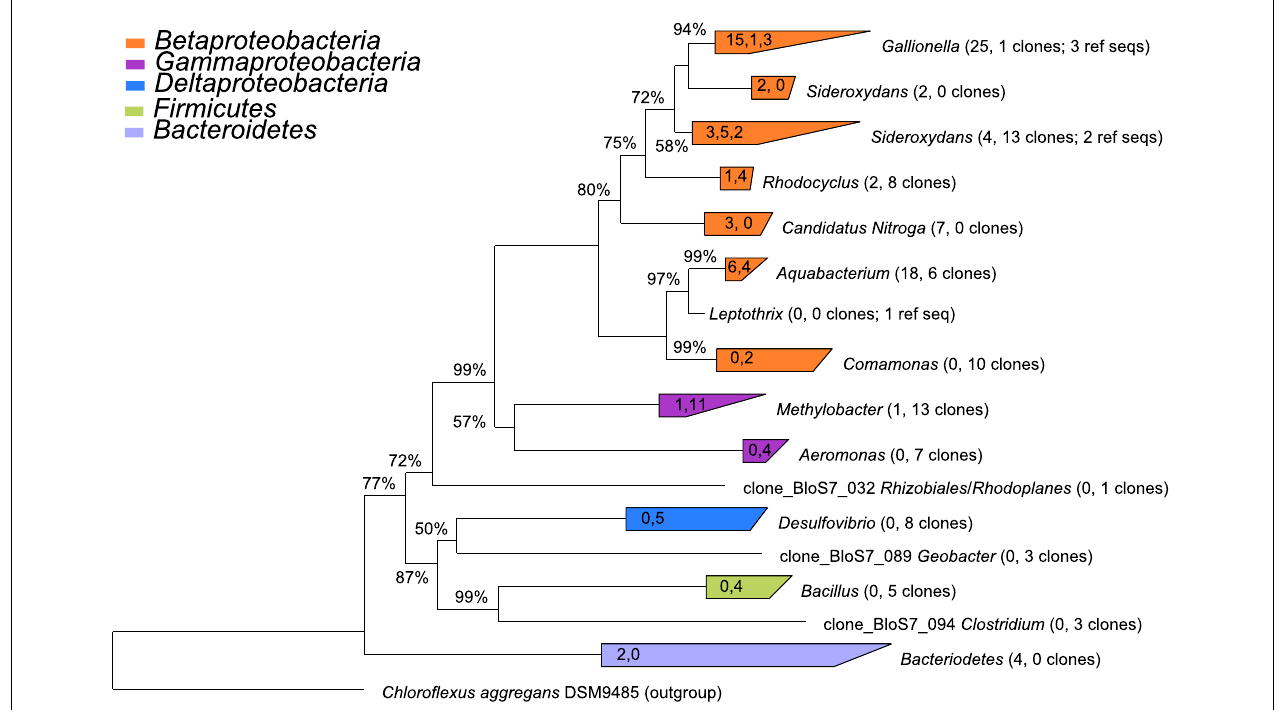
clones from each site and the number of reference sequences used to construct the tree in arb, respectively (values separated by commas).The tree was prepared using neighbor joining analysis with Jukes–Canter correction. Percentages on nodes represent 1000 bootstrap analyses; only values greater than 50% are shown. More details on major taxa identified in each sample are provided in Table 3